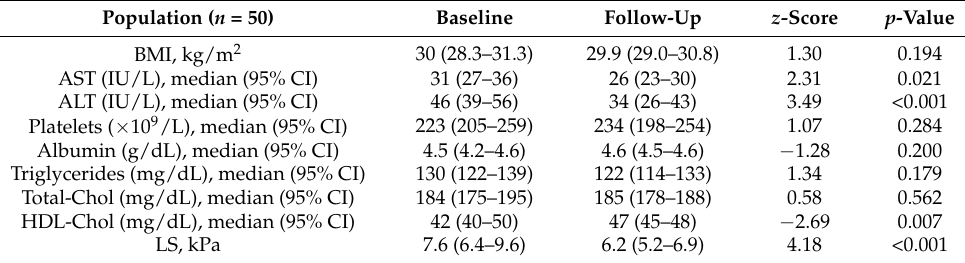
Table 4. Comparison of clinical, anthropometric, and biochemical characteristics between baseline and follow-up.